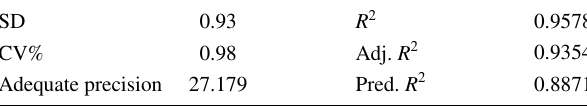
Table 6 Model coefficient for Pb(II) ion removal using